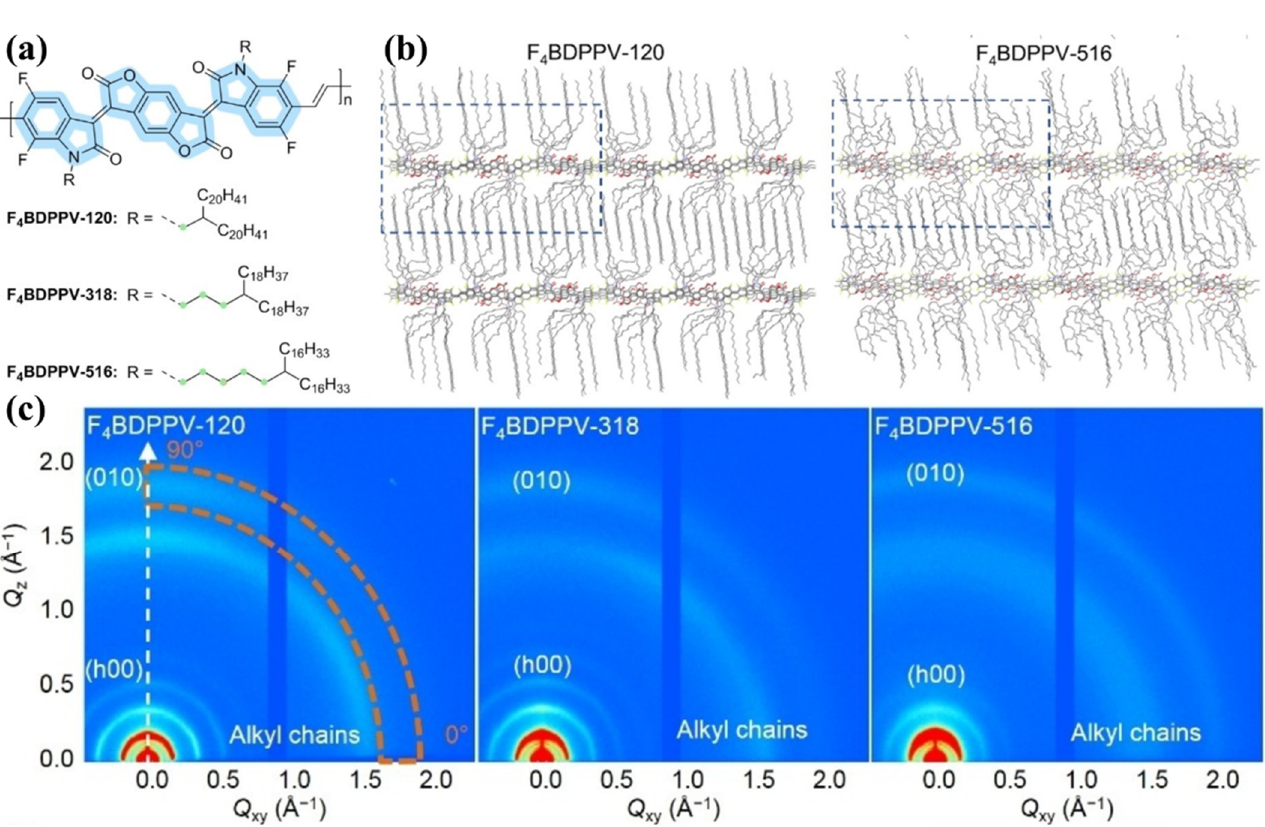
Figure 3. ( a ) Chemical structures of the three F 4 BDPPV polymers. ( b ) Equilibrated snapshots of packing structures extracted from MD simulations for F 4 BDPPV-120 and F 4 BDPPV-516. ( c ) 2D GIWAXS patterns of the three F 4 BDPPV polymers. These were adapted from reference [86] with permission from Copyright 2022 Wiley.